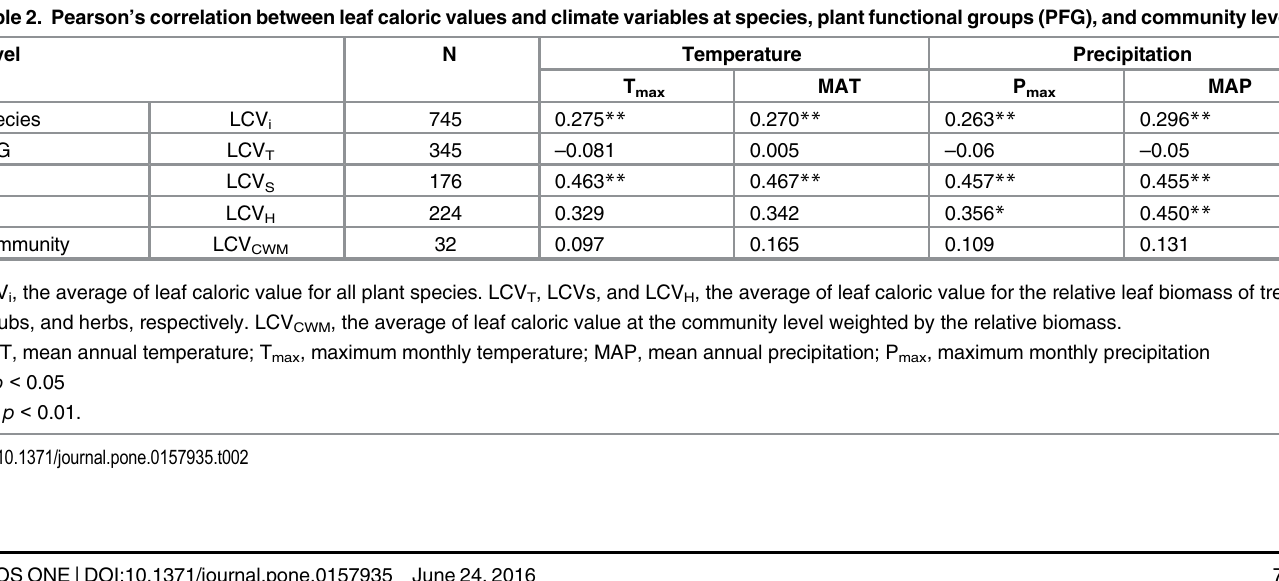
Table 2. Pearson ’ s correlation between leaf caloric values and climate variables at species, plant functional groups (PFG), and community levels. Level N Temperature Precipitation T max MAT P max MAP Species LCV i 745 0.275 ** PFG LCV T